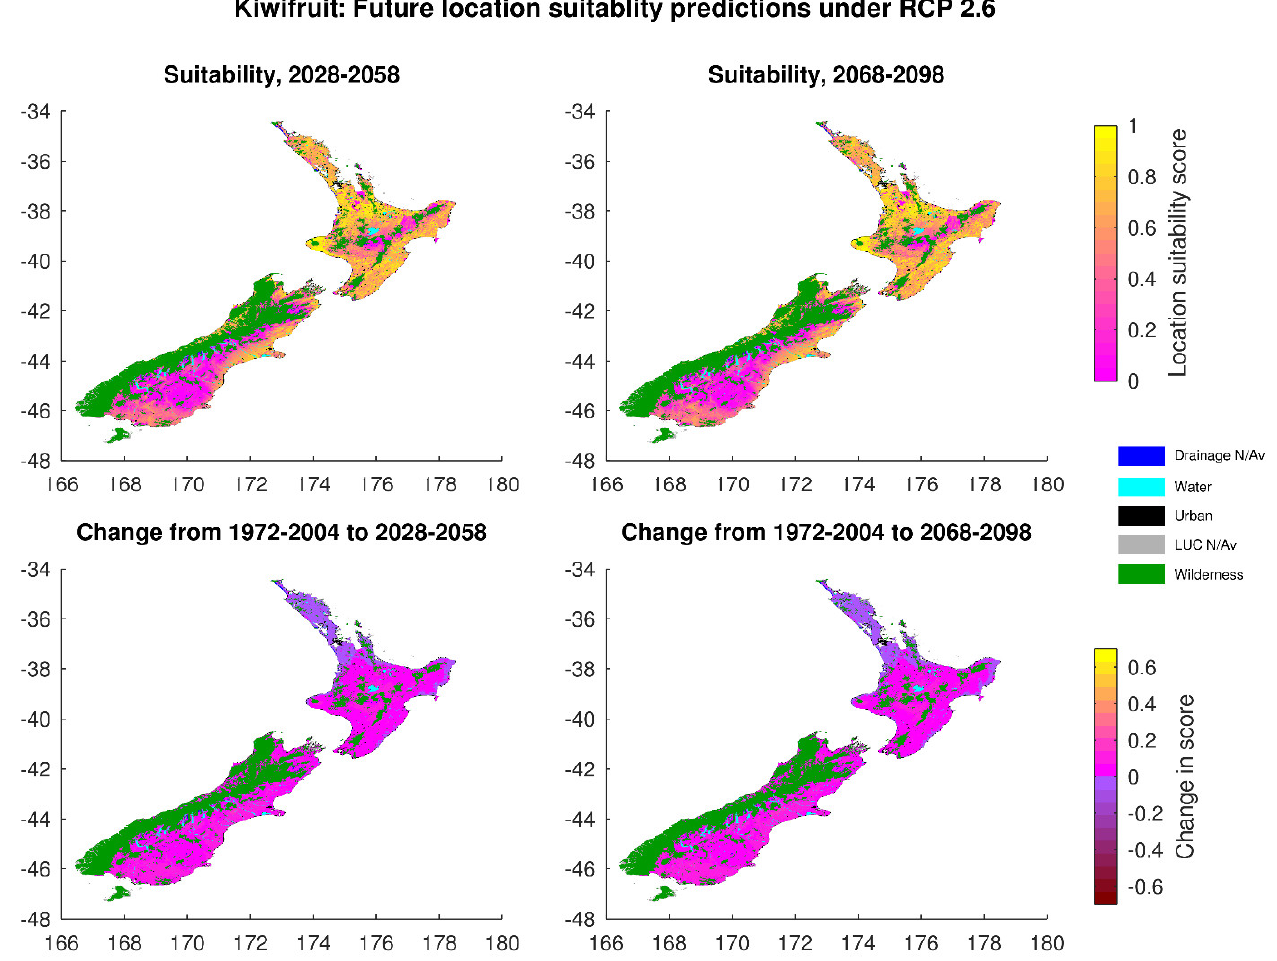
Figure 6. Kiwifruit: projected location suitability ( top panels) and projected changes in location suitability from the historic period ( bottom panels) for the mid-century ( left panels) and late-century ( right panels) in New Zealand under Representative Concentration Pathway (RCP) 2.6.